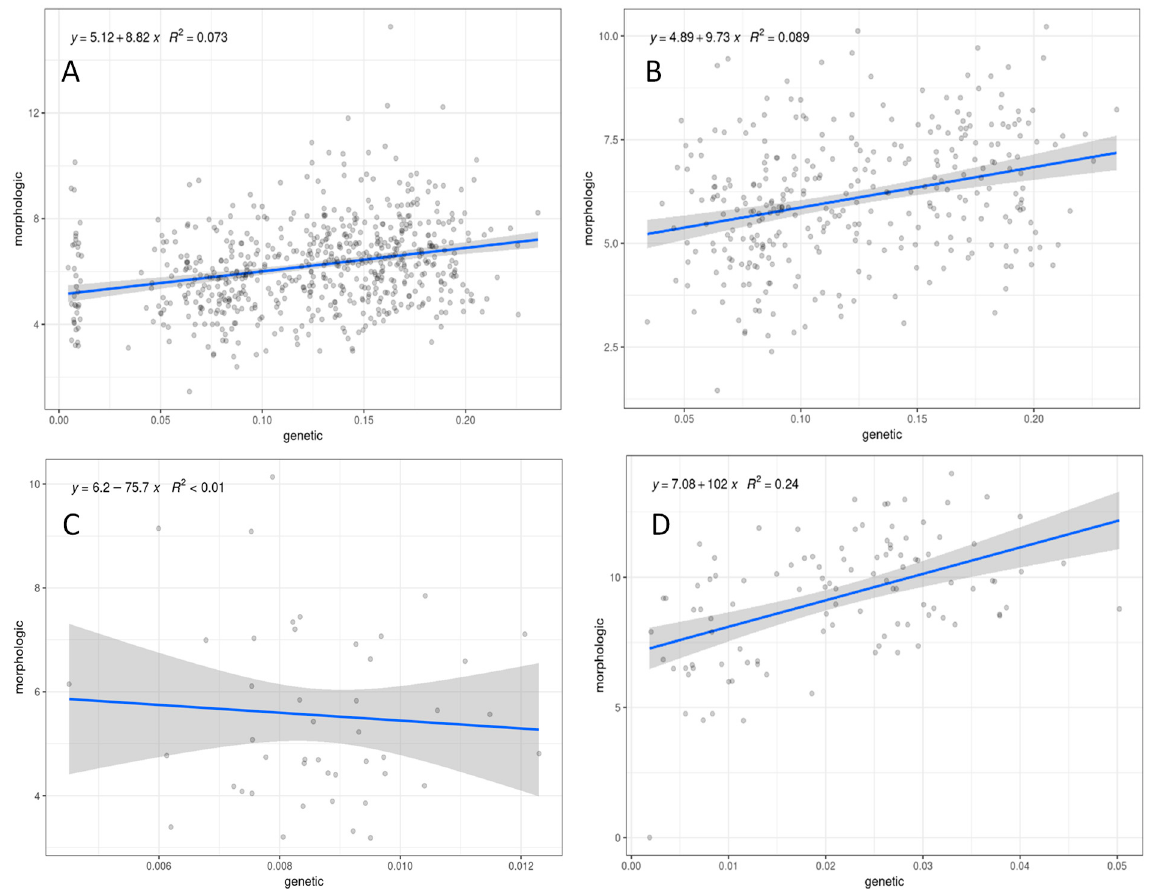
Figure 5. Euclidean distances using standardized morphological variables versus genetic distance for: ( A ) the Centaurea aspera individuals, ( B ) C. aspera diploid individuals (ssp. aspera , ssp. pseudosphaerocephala , ssp. stenophylla ), ( C ) C. aspera tetraploid individuals (ssp. gentilii ), and ( D ) tetraploid C. seridis individuals. The regression is represented by a blue line. The ribbon shows the 0.95 confidence interval.